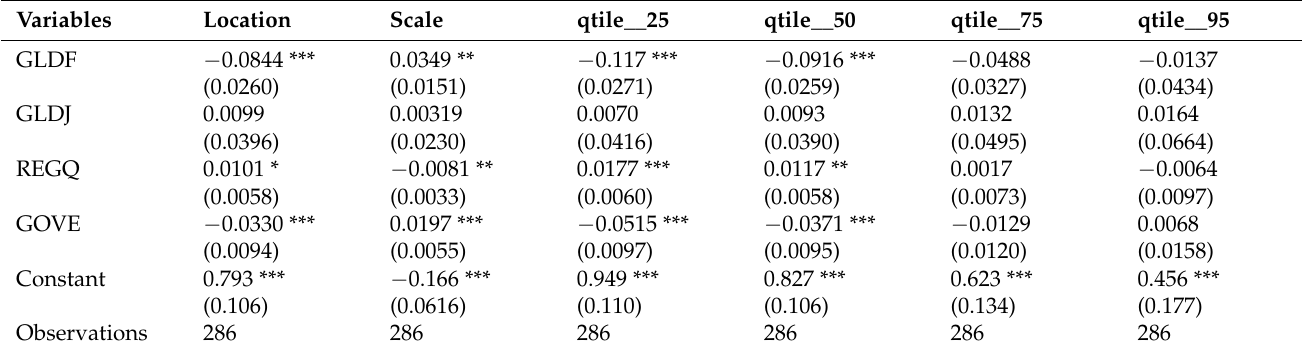
Table 5. Model 3. DV: Income Share of the Top 10% (IN2).